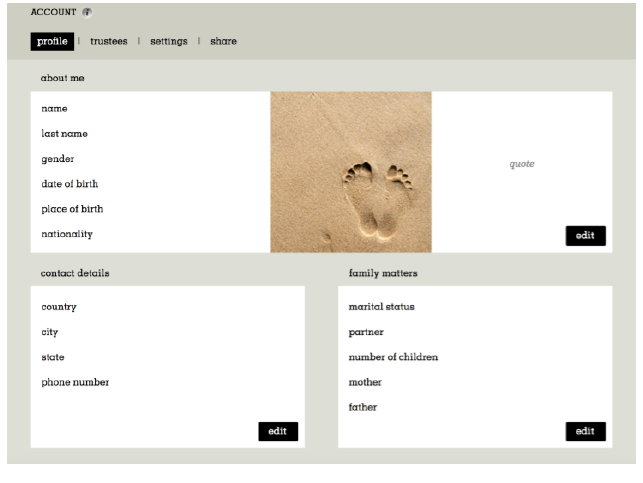
11. Afternote account page. Image taken from site: